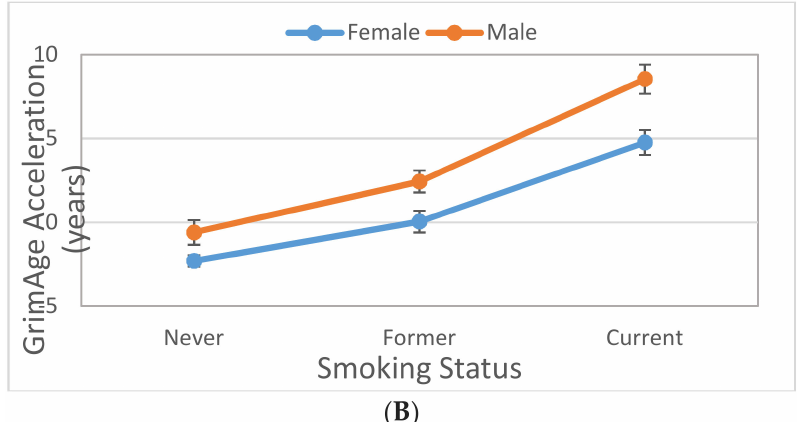
Figure 1. The plots show ( A ) the education e ff ect on GrimAge Acceleration, and ( B ) the smoking e ff ect on GrimAge Accelerations in men (orange line) vs. women (blue line). Each dot represents the least square mean of GrimAge Acceleration for each lifestyle factor-by-gender category, and the bars represent the corresponding confidence intervals for the e ff ect estimate. HS: High School; GED: General Education